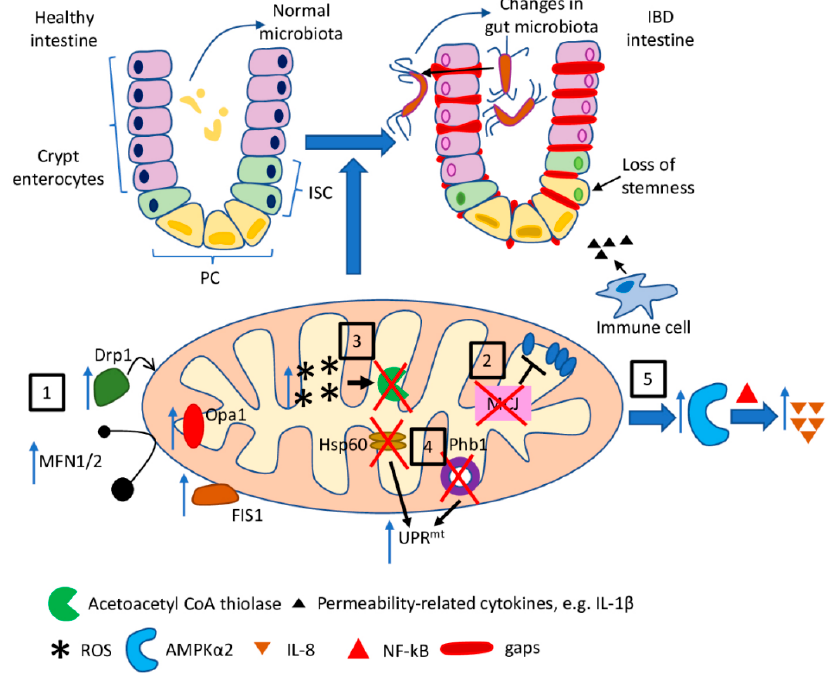
Figure 2. The role of mitochondria dysfunction in IBD. Mitochondria dysfunction observed in the course of inflammatory bowel diseases, as well as in experimental models of IBD, and the resultant features of the disease: (1) increased expression of fission- and fusion-related proteins (Fis1, Drp1, Opa1, MFN1/2) leads to disturbance in mitochondrial dynamics; (2) loss of MCJ results in the impaired regulation of ETC; (3) increased mitochondrial ROS production is a possible cause of the impairment of acetyl CoA thiolase leading to disturbances in mitochondrial β -oxidation of butyrate; (4) activation of UPR mt (a) as a consequence of Phb1 deletion in IEC and PC and (b) due to IEC- specific loss of Hsp60 results in the loss of stemness in the intestinal crypts; (5) reduced mitochondrial activity leads to activation of AMPK α 2 and subsequent NF- κ B-dependent IL-8 expression.